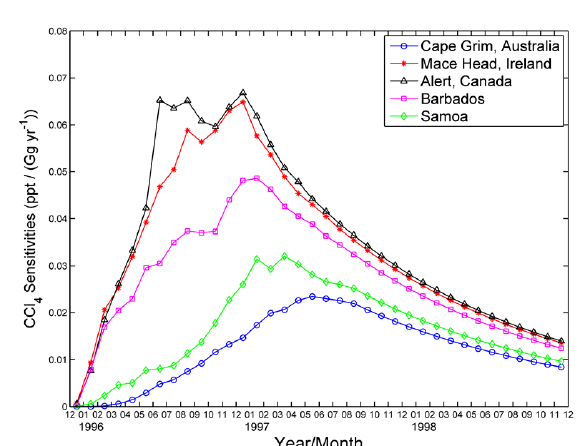
Fig. 4. MATCH-modeled and extrapolated sensitivities of CCl 4 mole fractions (ppt) to a 1996 annual emission pulse from the Southeast Asian (SE Asia) industry (Gg yr -1 ), plotted as monthly means at selected atmospheric measuring stations. The extrapolated sensitivities in this case extend from September 1997 to August 2005, but here only three years of sensitivities are shown.